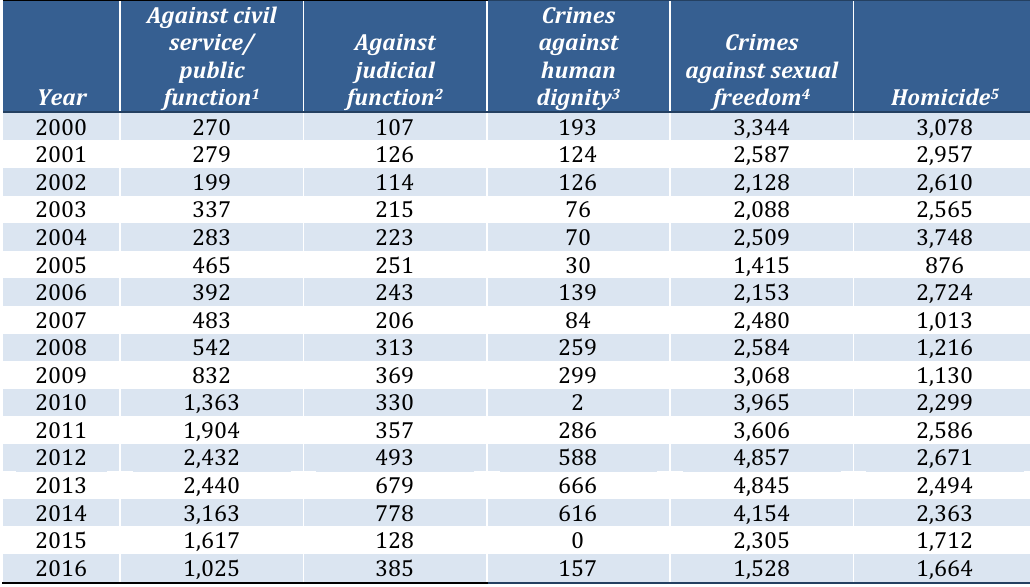
Table 2: Offences reported by police according to committed